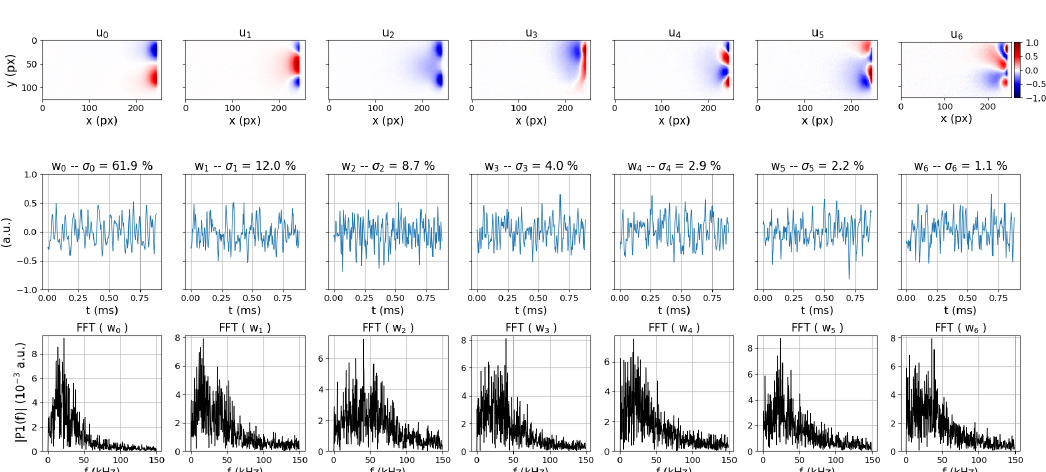
over the sum of all the λ i i